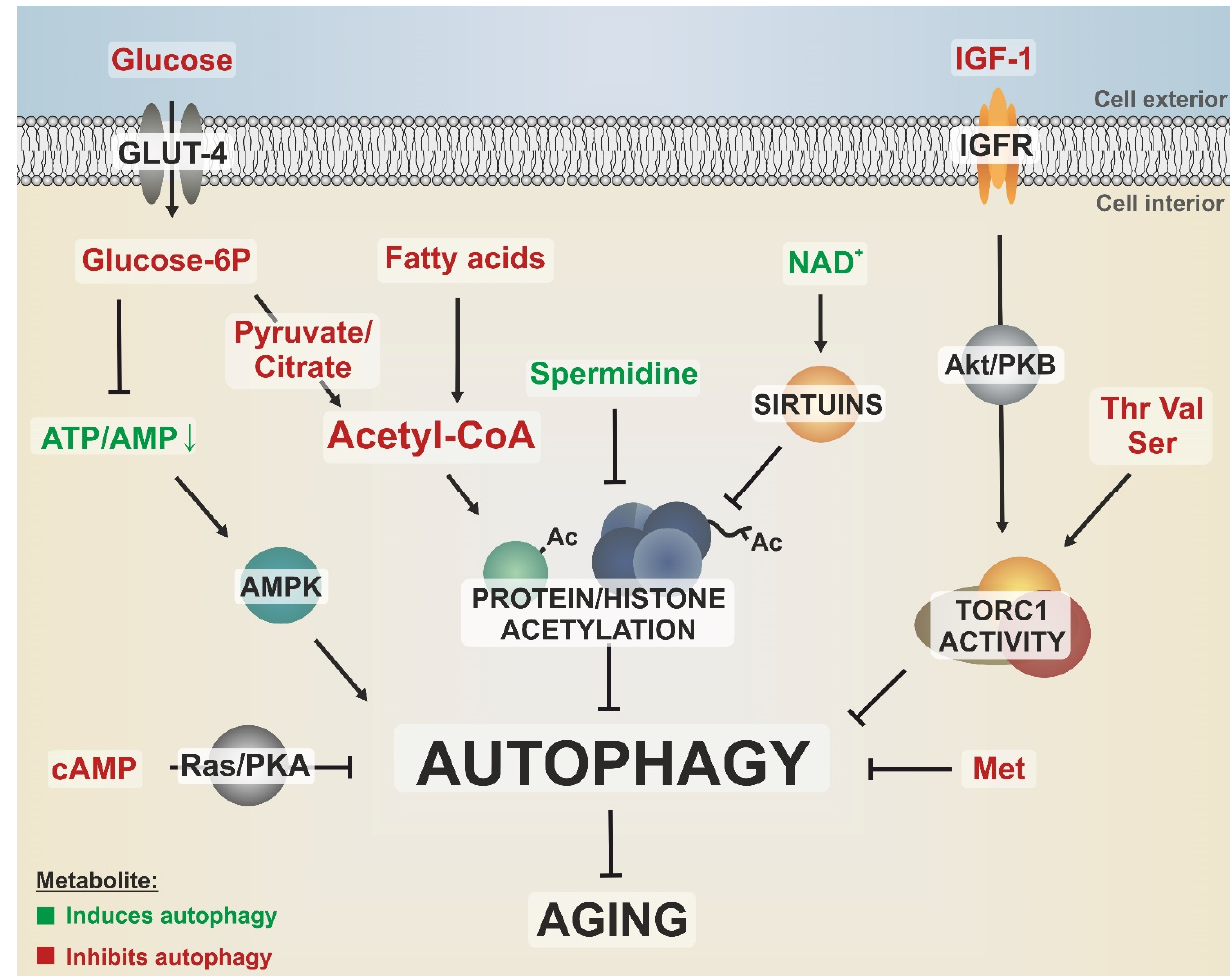
FIGURE 1: Different metabolites converge on pathways that regulate autophagy and aging. Dietary nutrients like glucose, amino acids and fatty acids as well as growth signaling by IGF-1 activate nutrient-sensing kinases, like the target of rapamycin complex 1 (TORC1), which stalls autophagy via phosphorylation of downstream targets. Furthermore, autophagy is negatively regulated by the Ras/PKA pathway, which responds to nutrient availability by sensing intracellular cAMP levels. The cellular energy status is reflected by the ATP/AMP ratio, which is sensed by the autophagy activator AMPK. Methionine downregulates autophagy during aging in a yet to be elucidated fashion. The central energy intermediate acetyl-CoA integrates metabolites from glycolysis, β-oxidation or respiration and fuels acetylation of proteins such as histones, resulting in decreased autophagic flux. All these autophagy-limiting metabolic pathways have been linked to an accelerat- ed aging phenotype. In contrast, polyamines, like spermidine, reduce protein acetylation, thereby promoting autophagy and longevity. Po- tential crosstalks between protein acetylation and nutrient sensing kinase signaling are yet to be elucidated. GLUT-4, glucose transporter 4; IGFR, IGF-1 receptor; Ac, acetyl-group; amino acids are indicated by three-letter